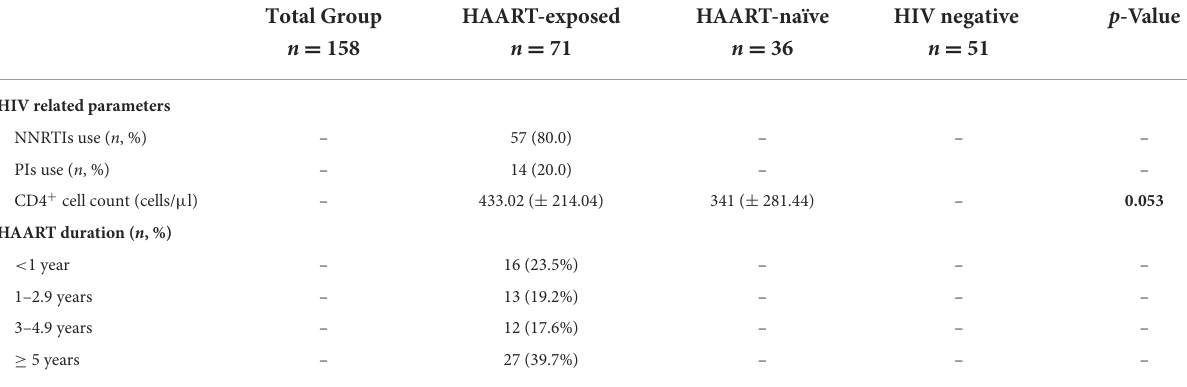
TABLE 2 HIV and HAART-related characteristics of the study